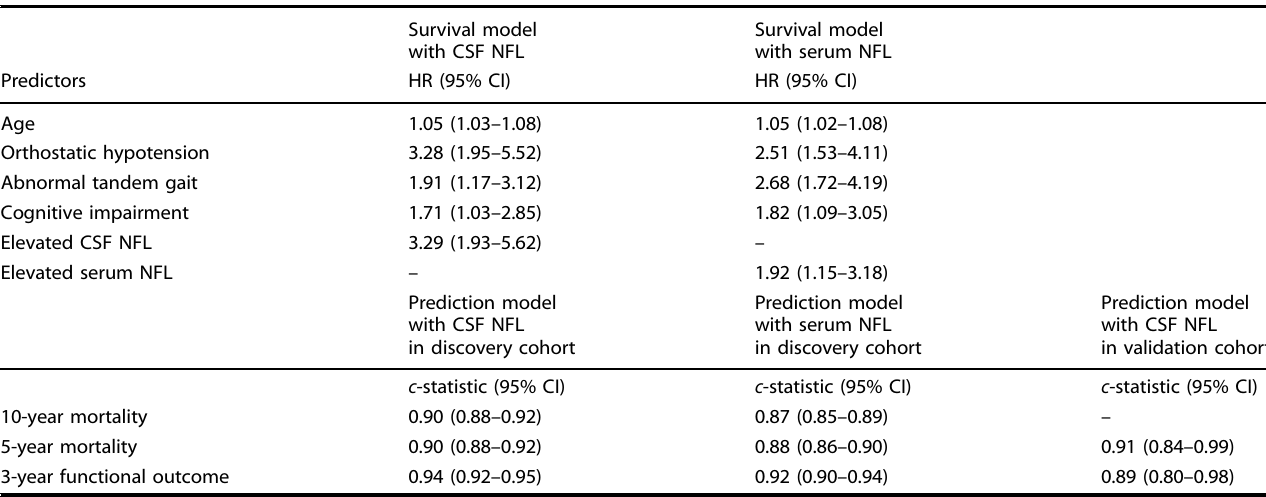
Table 3. Predictors of mortality in uncertain cases of (new-onset) parkinsonism.